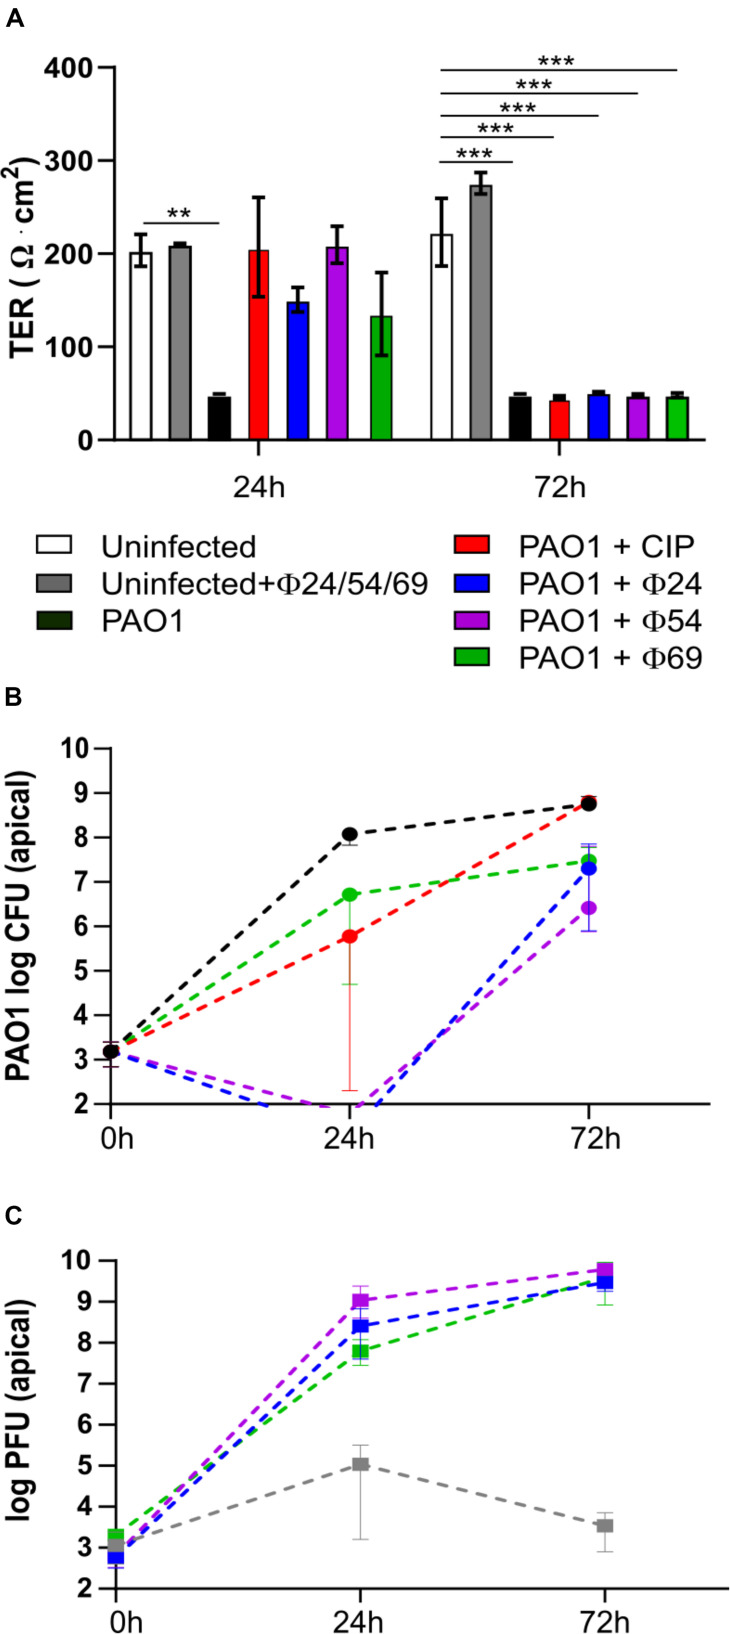
Measurement of trans-epithelial resistance (TER), CFU and PFU at 24 and 72 h p.i. of Calu-3 cells infected by P. aeruginosa PAO1 and treated by ciprofloxacin (CIP) or phages. (A) Single phage or CIP rescued PAO1-infected wild type Calu-3 cells at 24 h but not at 72 h p.i. (B) PAO1 viability is reduced at 24 h by phage or CIP but returns to almost untreated control levels after 72 h p.i. (C) phage replication increases during 72 h in wells containing PAO1 bacteria. Values represent mean and SEM (panel A), and median and range (panels B,C) of three independently performed experiments. Differences in TER between the conditions were assessed using a one-way ANOVA; **p < 0.01, ***p < 0.005.